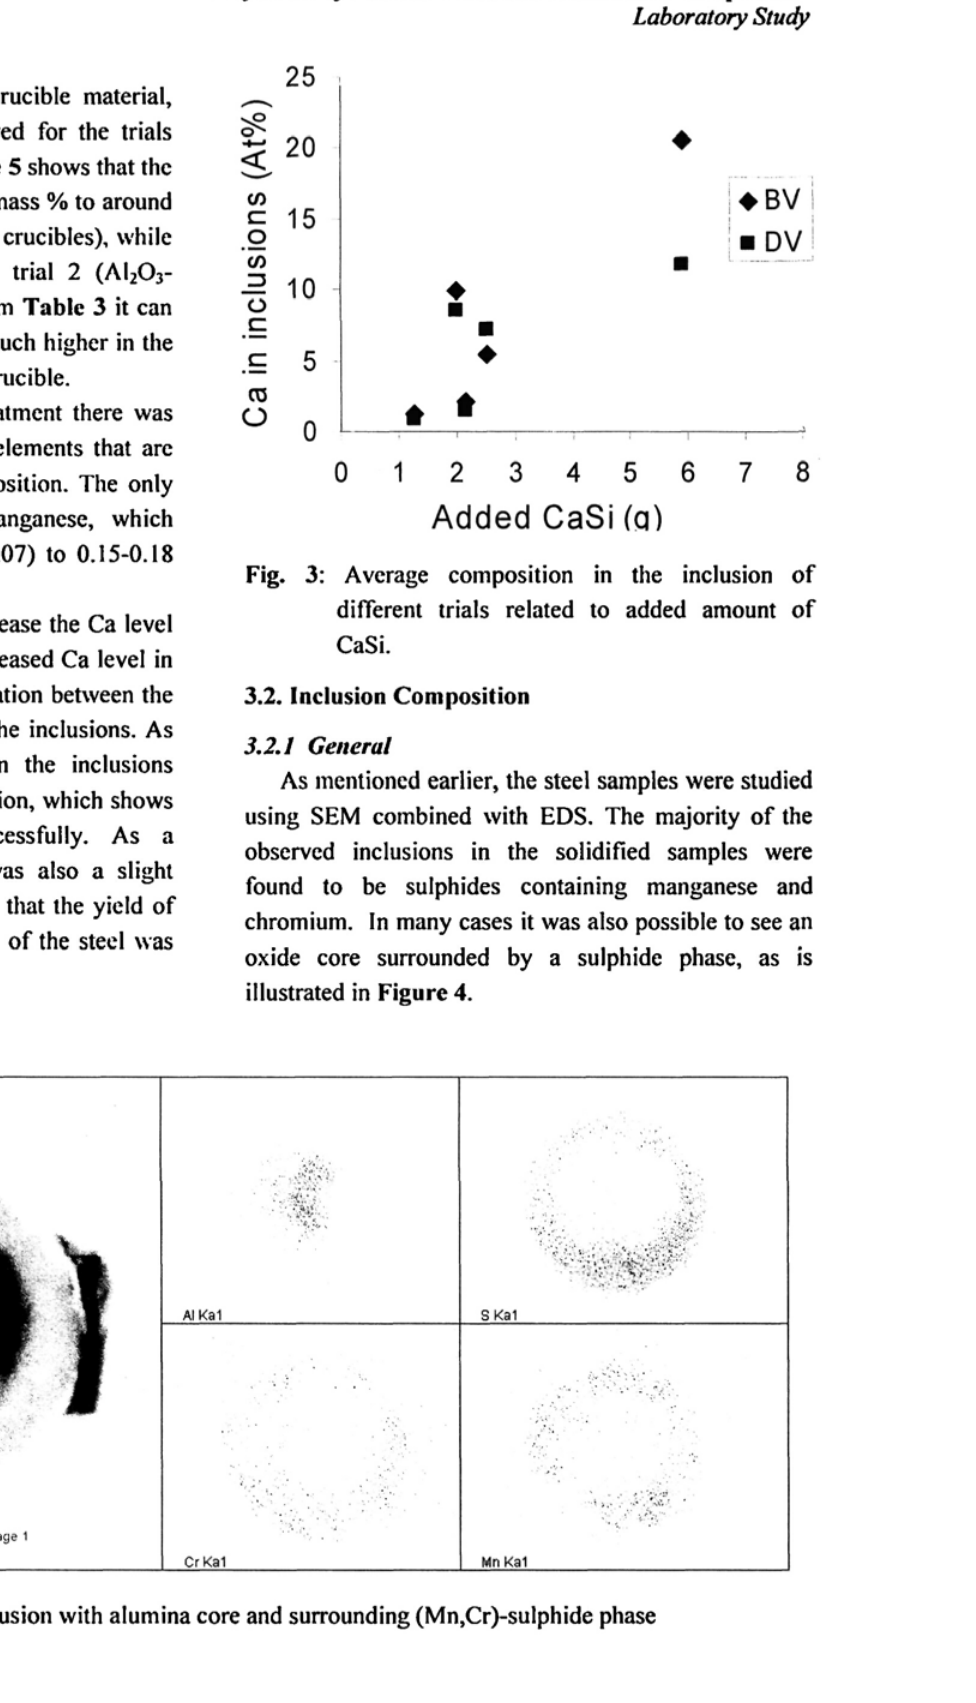
Fig. 4: Example of inclusion with alumina core and surrounding (Mn,Cr)-sulphide phase